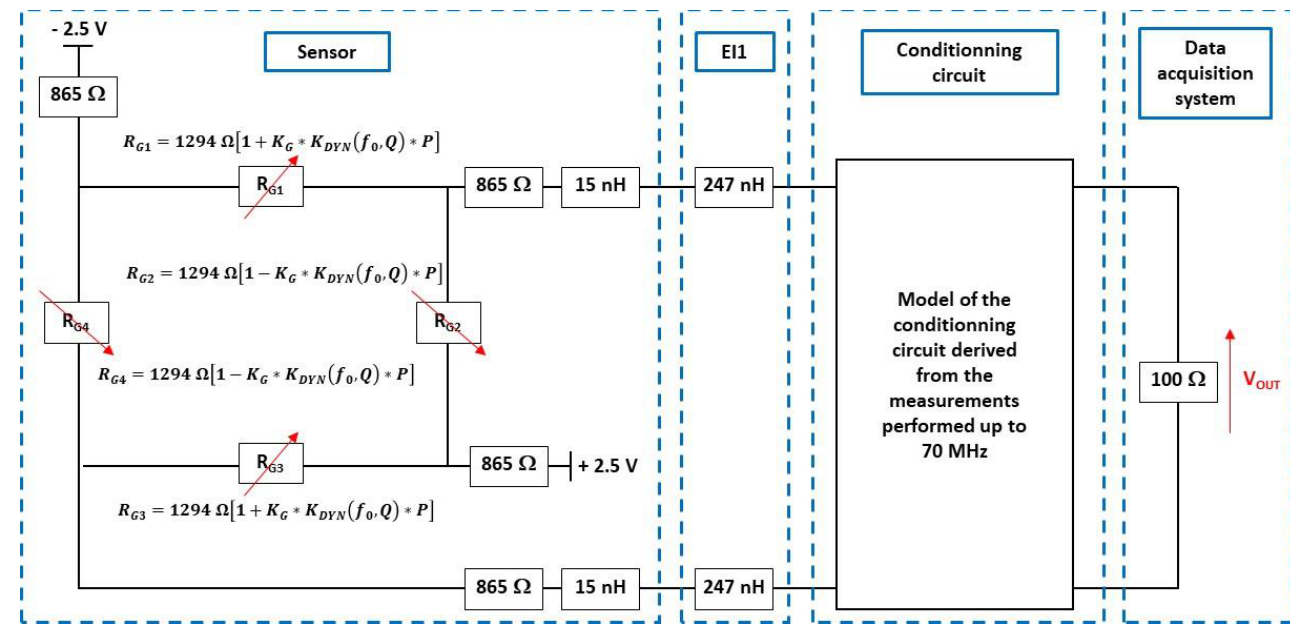
OUT to a pressure step of 10 bars.